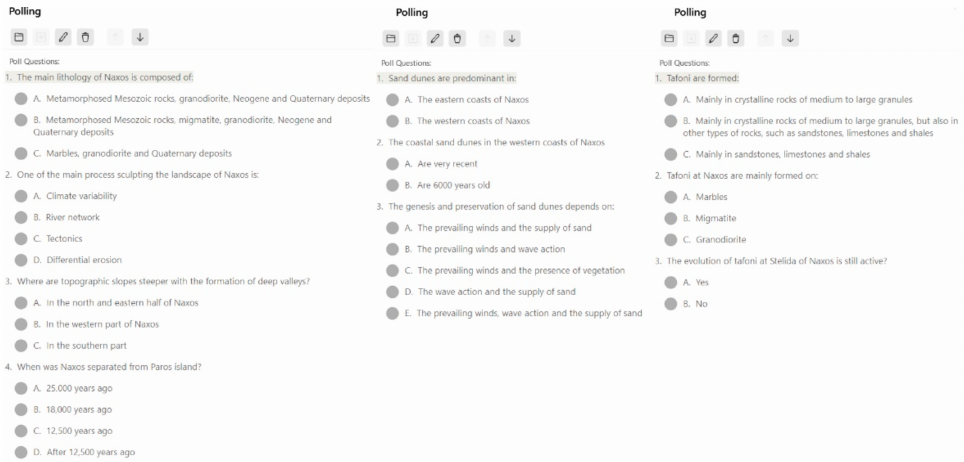
Figure 2. Questionnaire that was created for the evaluation of the VFT using ArcGIS Survey123. The questionnaire is available at the following link: https://arcg.is/1nm8Hj (accessed on 16 June 2022).